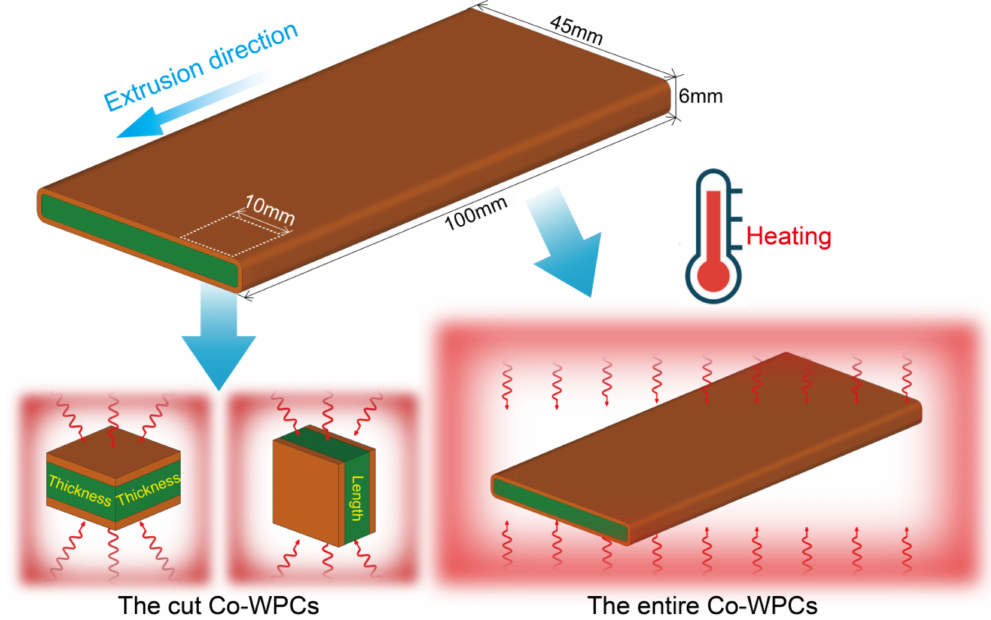
Figure 1. Schematic of the cut and entire Co-WPCs samples for thermal expansion tests.